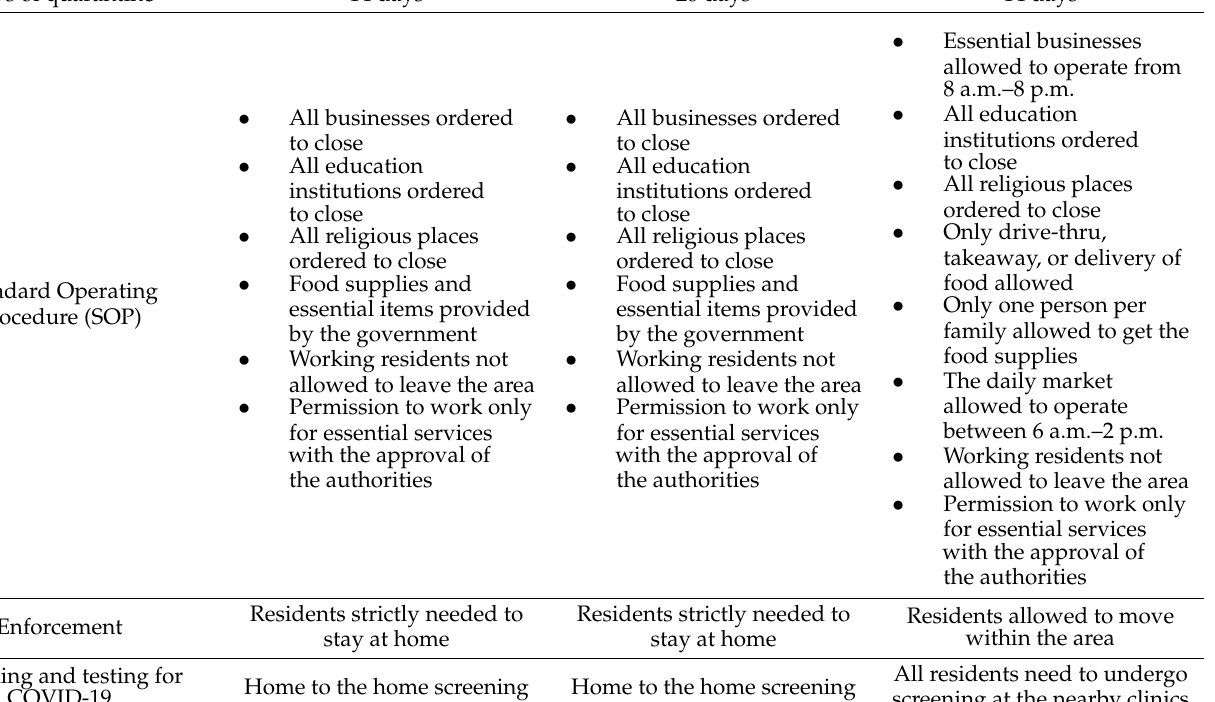
Table 2. The different approaches taken by the Malaysian government in containing the local infection of COVID-19. EMCO Coverage